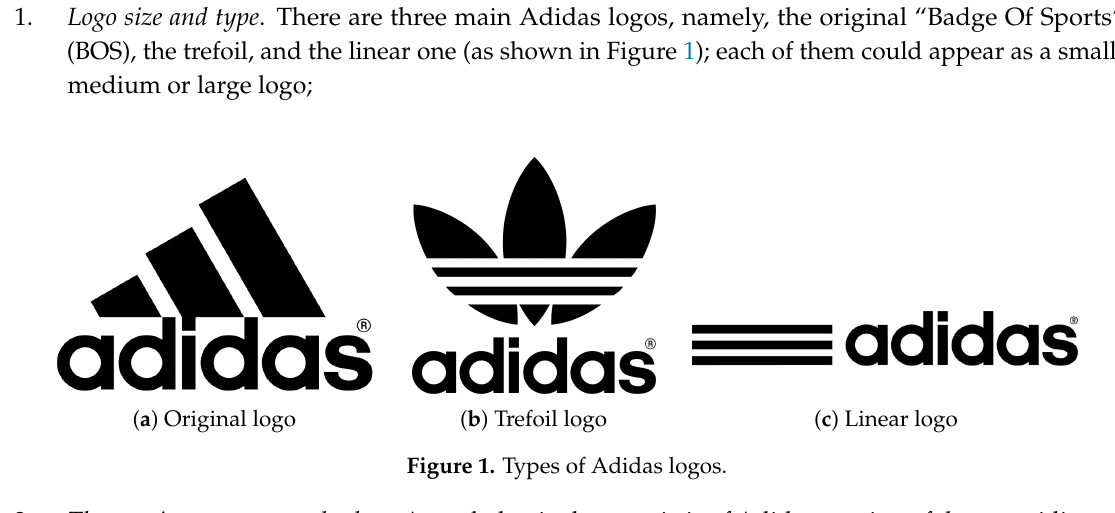
Figure 1. Types of Adidas